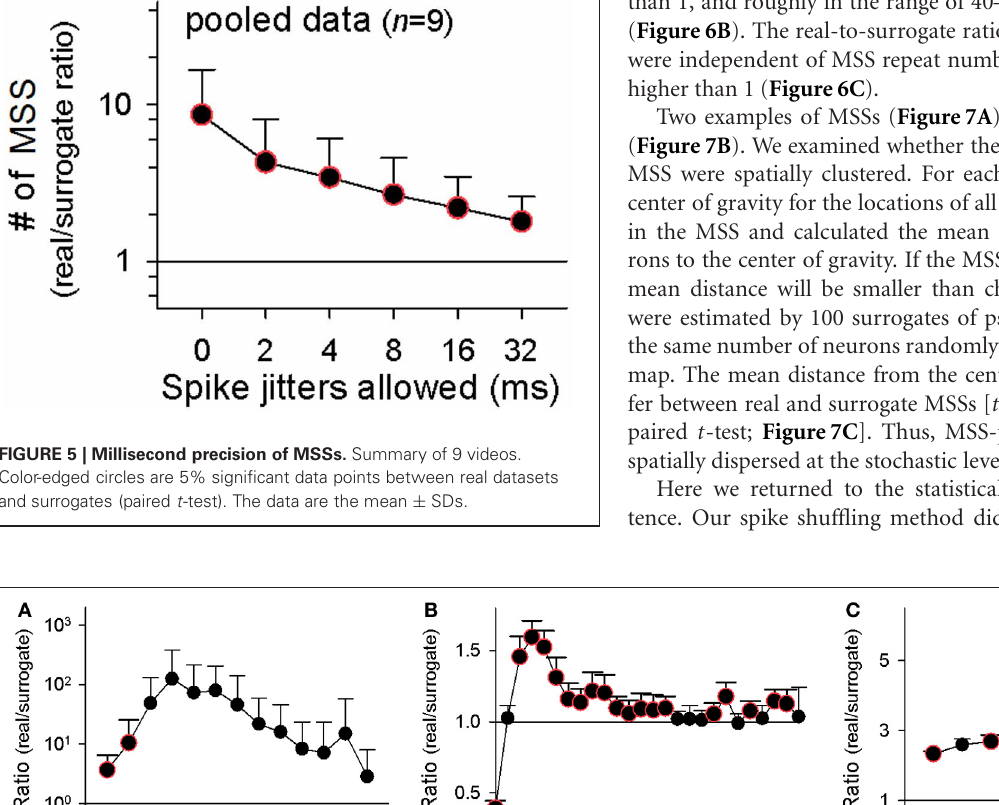
FIGURE 6 | Characterization of MSSs. (A–C) The number of cells that participated in individual MSSs (A) , the duration that individual MSS events persisted (i.e., the time intervals between the first and last spikes within MSSs) (B) , and the number of repetitions of MSSs (C) are shown